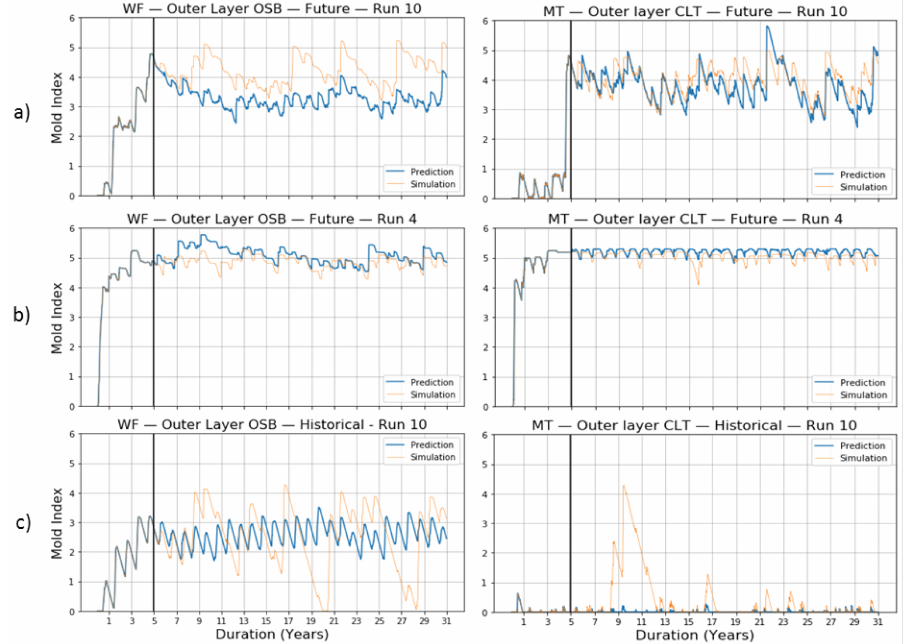
Figure 10. Comparisons of mold index calculated using temperature and relative humidity predicted from SVR and simulated using DELPHIN for the outer layer of OSB in wood frame (WF) and outer layer of CLT in mass timber (MT) walls in the city of ( a ) Ottawa, ( b ) Vancouver, and ( c ) Calgary. Table 2. Summary statistics for forecasting temperature for the three cities. Wood Frame Wall Massive Timber Wall City